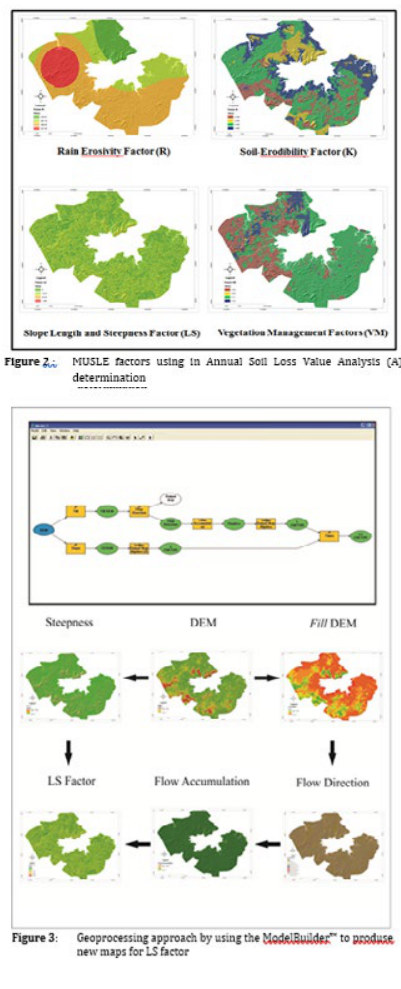
Figure 3: Geoprocessing approach by using the ModelBuilder™ to produse new maps for LS